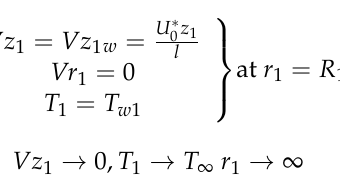
Figure 1. Pictorial representation of the problem. With boundary conditions (see